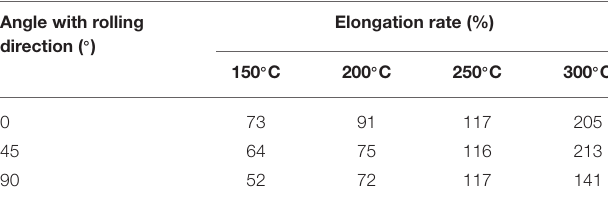
TABLE 1 | Tensile elongation in all directions at different